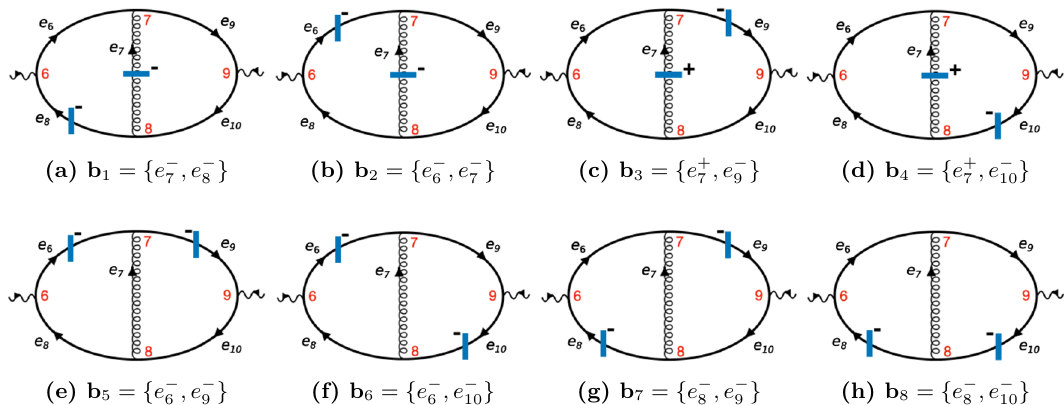
Figure 3. The eight loop momentum bases (the inverse of spanning trees) resulting from applying the LTD expression of ref. [88] to the double-triangle topology. The cut structure σ b i is reported both in the drawings as signs placed next to the LTD cuts as well in the captions as a superscript of the edge